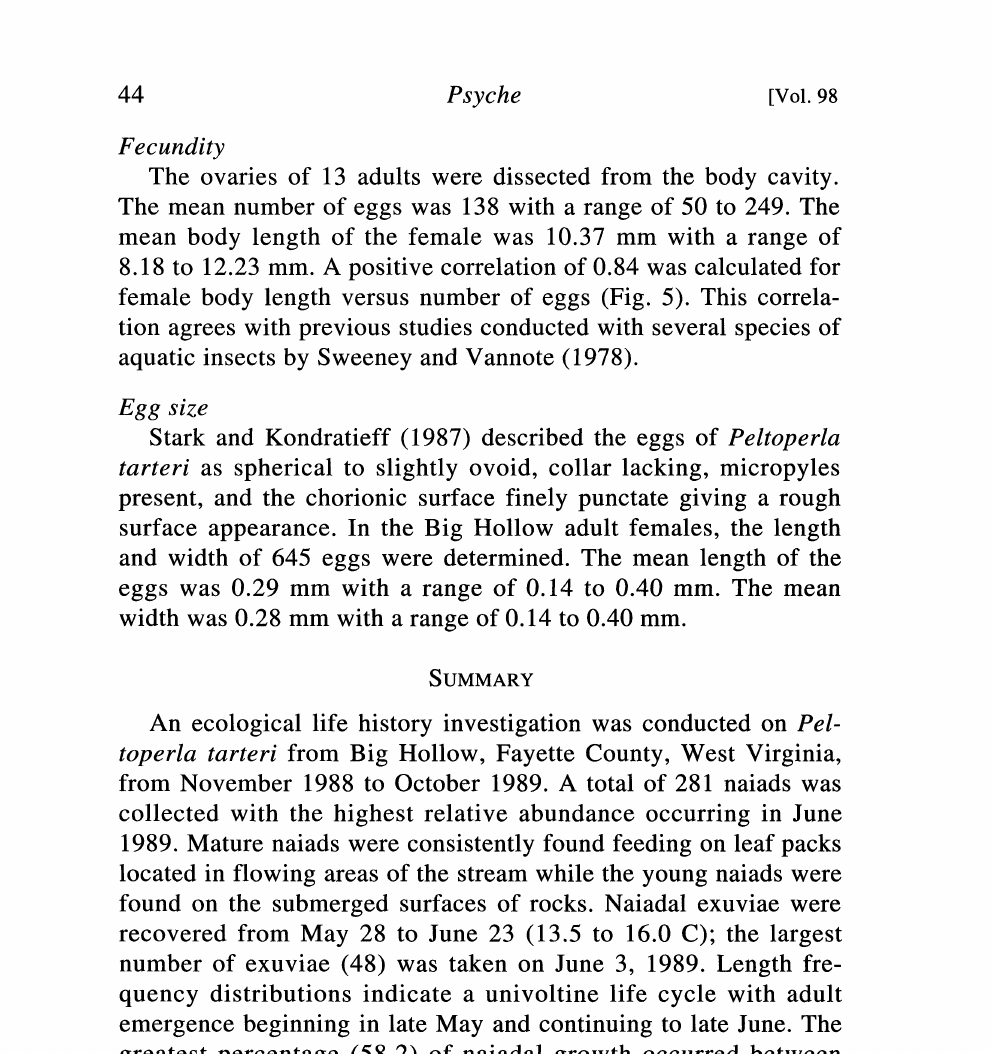
Figure 5. (Facing page.) Regression line of body length and number of eggs of adult Peltoperla